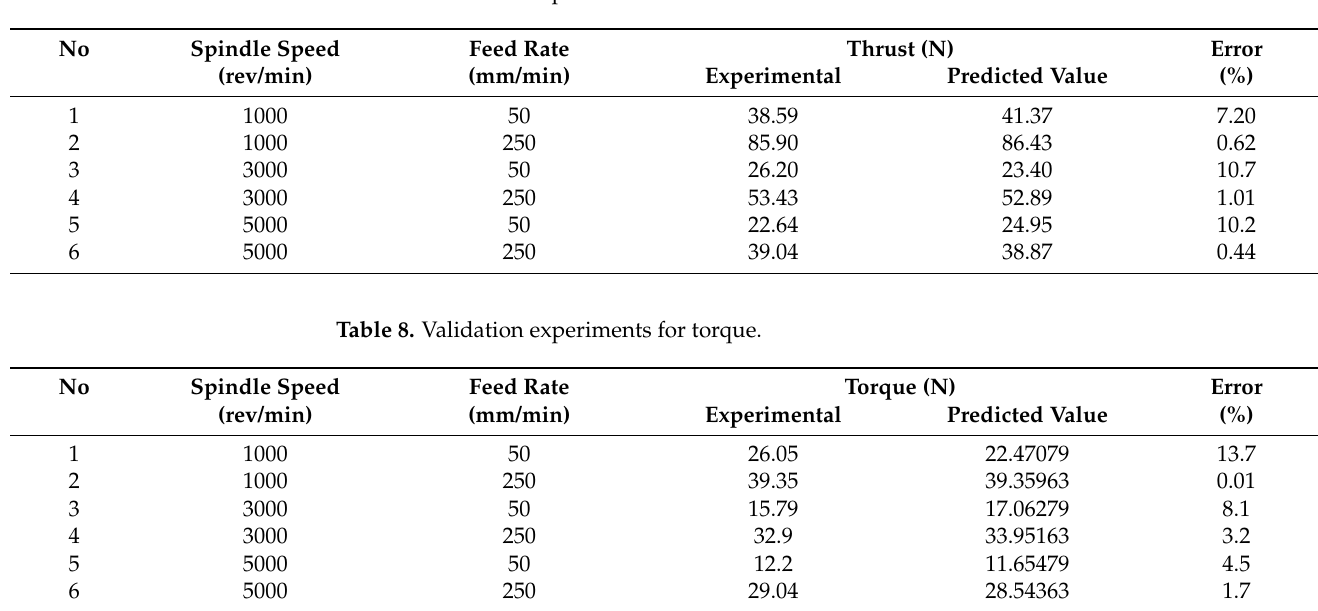
Table 7. Validation experiments for thrust.